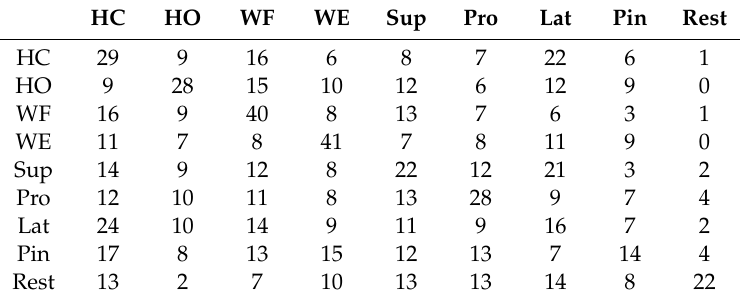
Table 7. Confusion matrix based on between-session calibration (the mean across the two days have been calculated) using autoencoders. All values are in percent and presented as the mean across participants. HC (Hand Close), HO (Hand Open), WE (Wrist Extension), WF (Wrist Flexion), Sup (Supination), Pro (Pronation), Lat (Lateral Grasp), and Pin (Pinch Grasp).